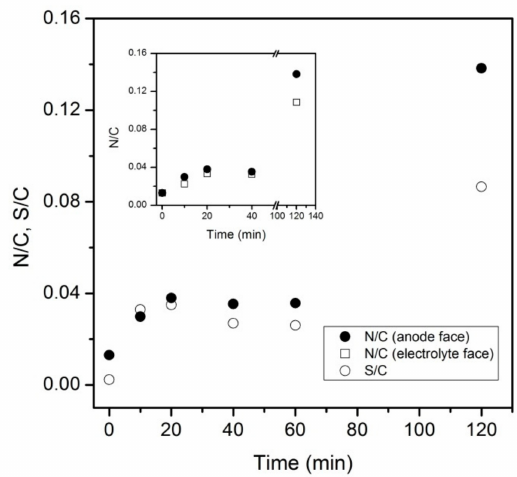
Figure 4. Evolution of surface N / C and S / C ratios for PAni-ACC composites as a function of the electropolymerization time. Inset: Comparison of N / C ratios at both sides of the